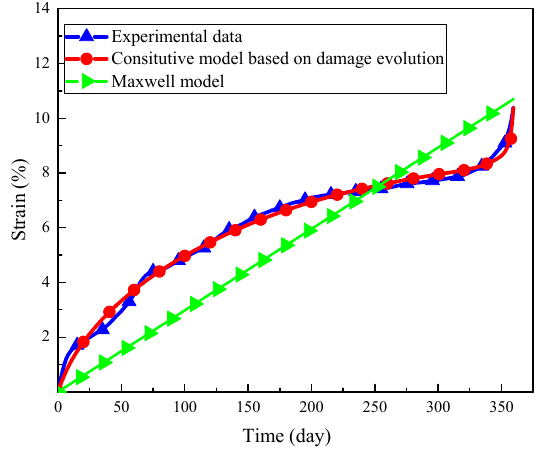
Figure 7. Experimental data and fitting curves. Table 1. Parameters determined by a fitting analysis based on creep tests of salt rock.